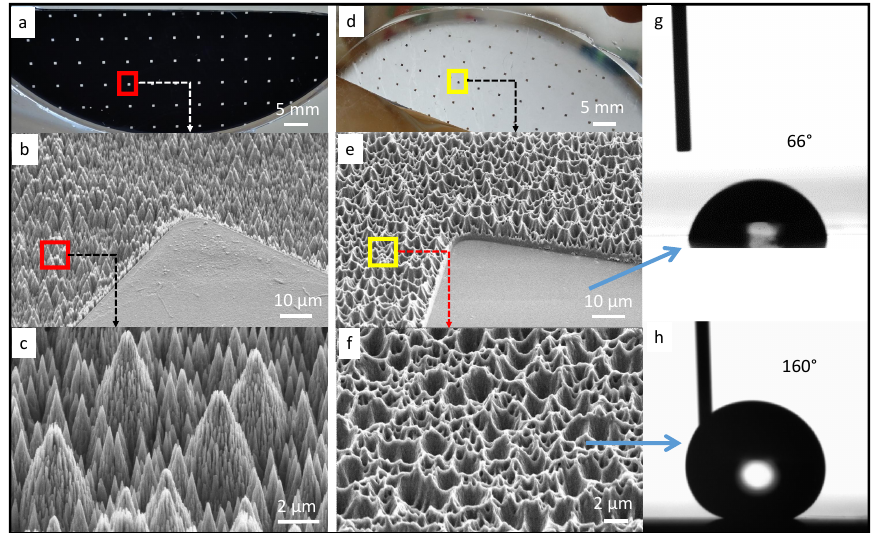
Figure 1. Patterned black silicon surface and PDMS replicate: ( a ) 500 µ m ˆ 500 µ m SiO 2 pads surrounded by black silicon surface coated with fluoropolymer, with scanning electron micrograph in ( b ) and ( c ); ( d ) PDMS replicate with scanning electron micrograph in ( e ) and ( f ); ( g ) static water contact angle of 66 ˝ on the flat pad and ( h ) 160 ˝ on the nanostructured Trichlorosilane treated PDMS surface.